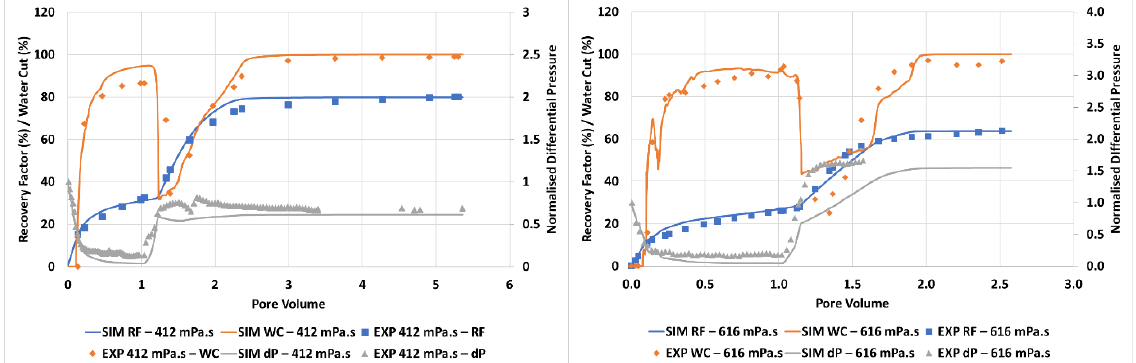
Figure 12. Simulation match of the unstable displacement of 412 mPa.s oil ( left ) and 616 mPa.s oil ( right ).